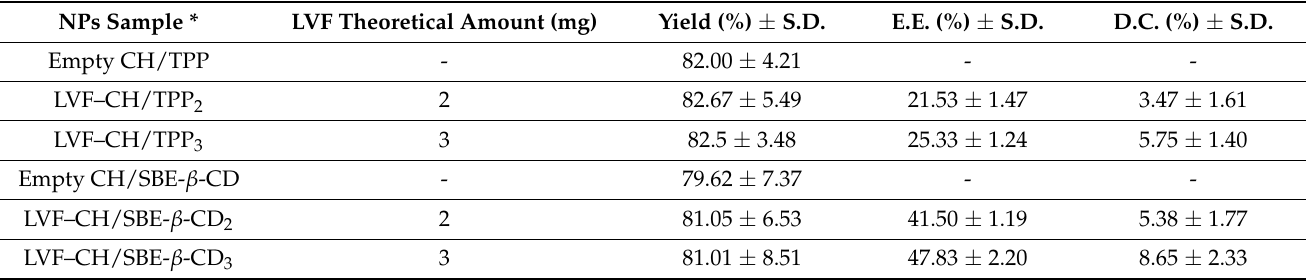
Table 2. Encapsulation efficiency (E.E.), drug content (D.C.), and yield percentage of CH/SBE- β -CD NPs and CH/TPP NPs loading LVF.